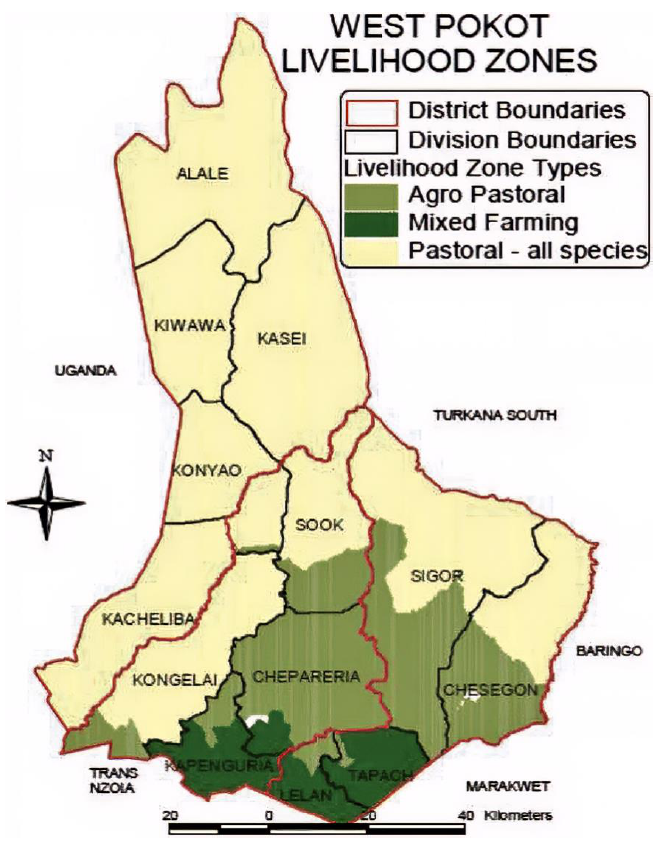
Figure 1. Map of West Pokot, Kenya, indicating the West Pokot County Livelihood Zones. Source: Adapted from the National Drought Management Authority (NDMA) (NDMA,